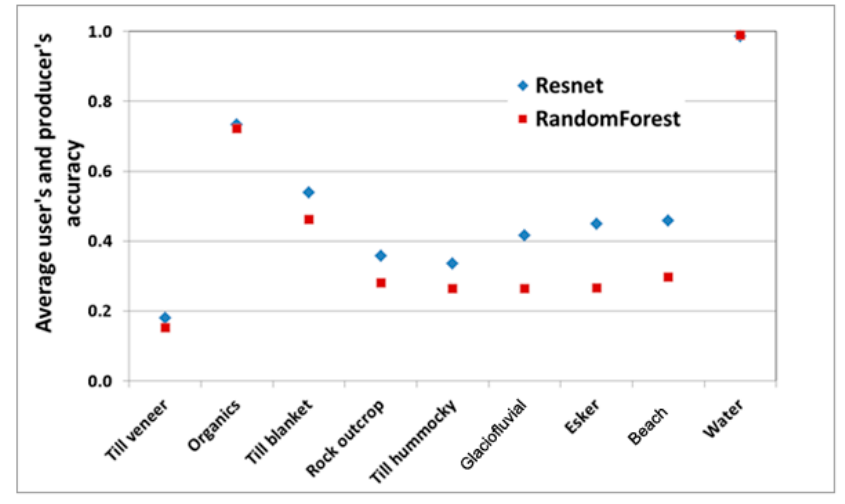
Figure 8. Accuracy of rare classes.